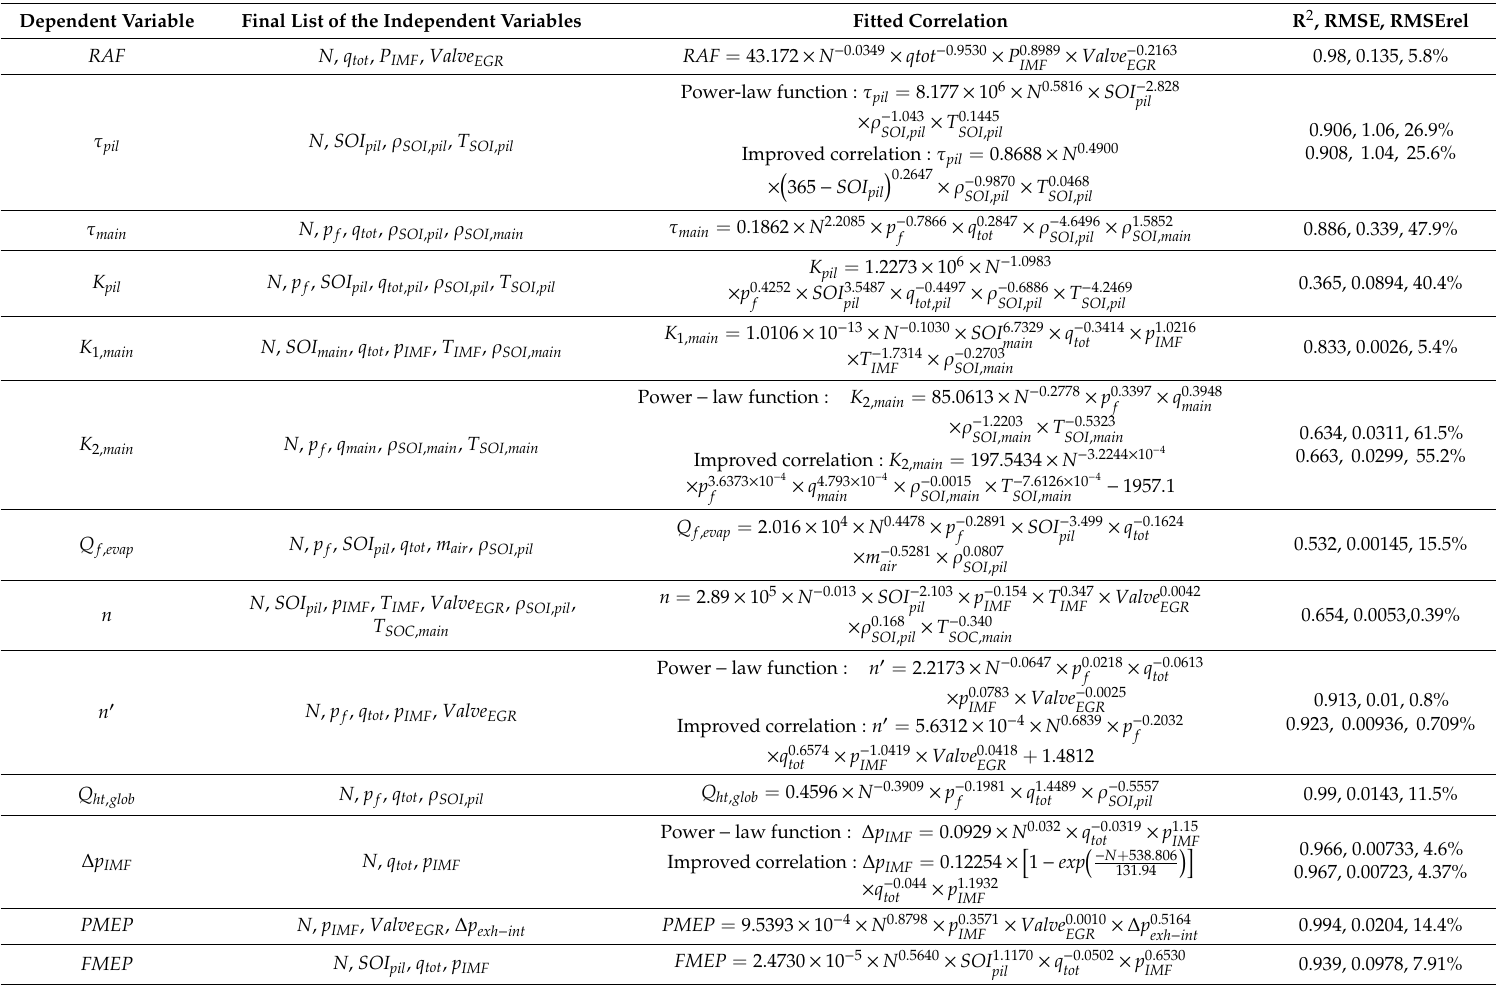
Table 4. Final list of the selected input variables, the related correlations, for each tuning parameter of the physics-based model and the corresponding fitting precision in terms of correlation coe ffi cient (R 2 ), root mean squared error (RMSE) and relative RMSE (RMSE rel